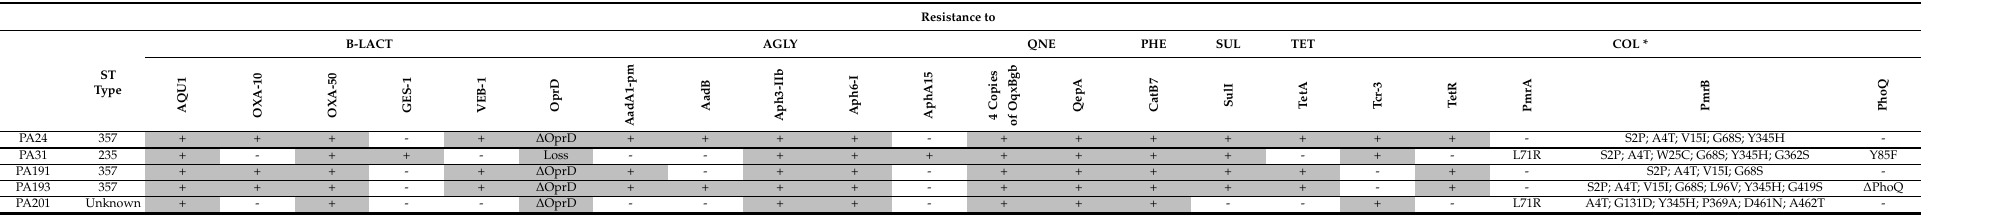
Table 3. Resistome of the five clinical P. aeruginosa isolates in this